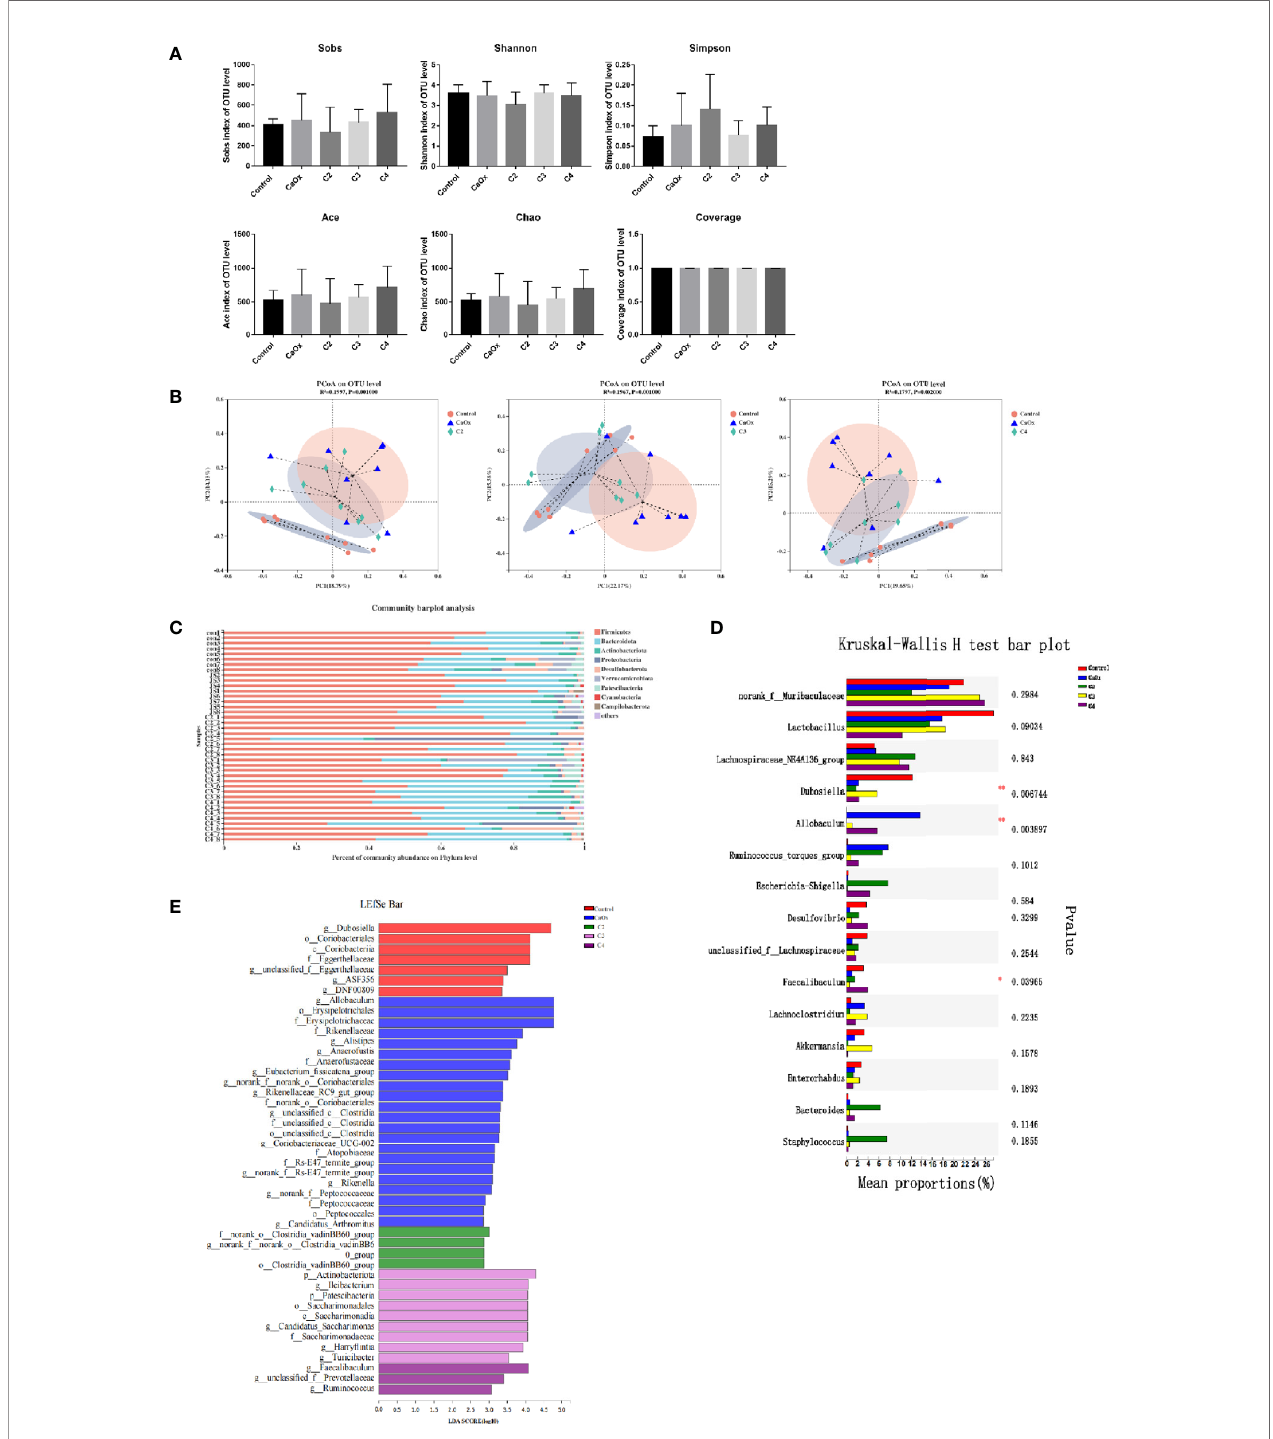
FIGURE 7 | Analysis of caecal microbiota among controls, CaOx mice and mice administration of SCFAs by using 16s rRNA. (A) Comparison of alpha diversity of gut microbiota among controls, CaOx mice and mice administration of C2, C3 and C4. Sobs, Shannon, Simpson, Ace, Chao, and Coverage indices at OTUs level were compared among groups by the Wilcoxon rank-sum test. (B) Comparison of beta diversity of gut microbiota among controls, CaOx mice and mice administration of C2, C3 and C4. PCoA score plot based on binary-pearson distance at OTUs level revealed classi fi cation of different groups. (C) The composition of gut microbiota in controls, CaOx mice and mice administration of C2, C3 and C4 at phylum level. (D) Different bacteria among groups using Kruskal-Wallis H test, *p < 0.05, **p < 0.01. (E) Bacteria with higher relative abundance in the fi ve groups by LEfSe